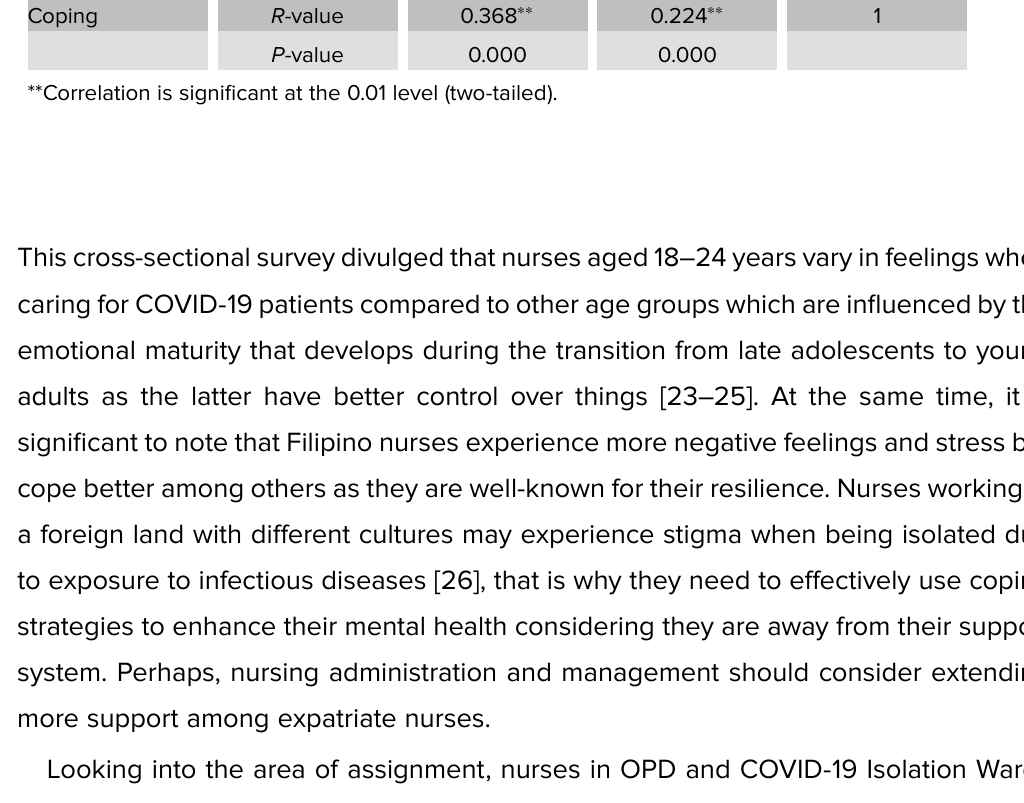
TABLE 5: Correlation between staff feelings during COVID 19, factors causing stress, and coping strategies Feeling Factors Coping strategies Feelings R -value 1 0.553 ∗∗ 0.368 ∗∗ P -value 0.000 0.000 Factors R -value 0.553 ∗∗ 1 0.224 ∗∗ P -value 0.000 0.000 Coping R -value 0.368 ∗∗ 0.224 ∗∗ 1 P -value 0.000